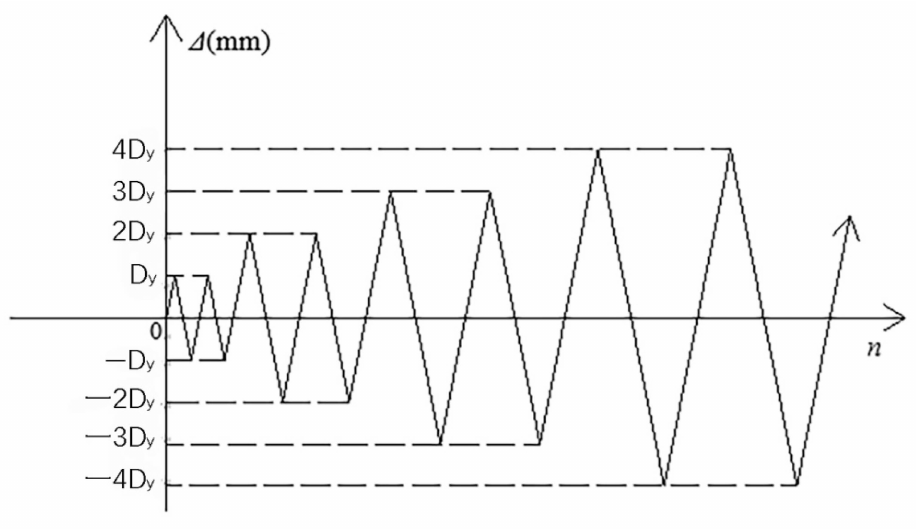
Figure 7. Loading